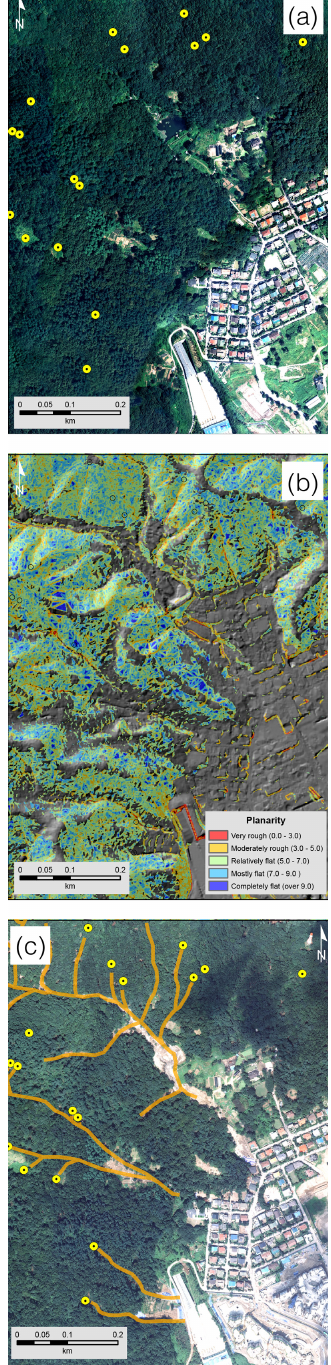
Figure 11. Feasibility evaluation of planarity in Site B. (a) Aerial photograph before the landslide (2009). Yellow circle with dot rep- resents the landslide initiation zone. (b) Modified planarity: areas outlined by a black circle with a diameter of 5m are the landslide initiation zones. (c) Aerial photograph after the landslide (2011). Orange lines indicate observed landslide routes from the landslide initiation